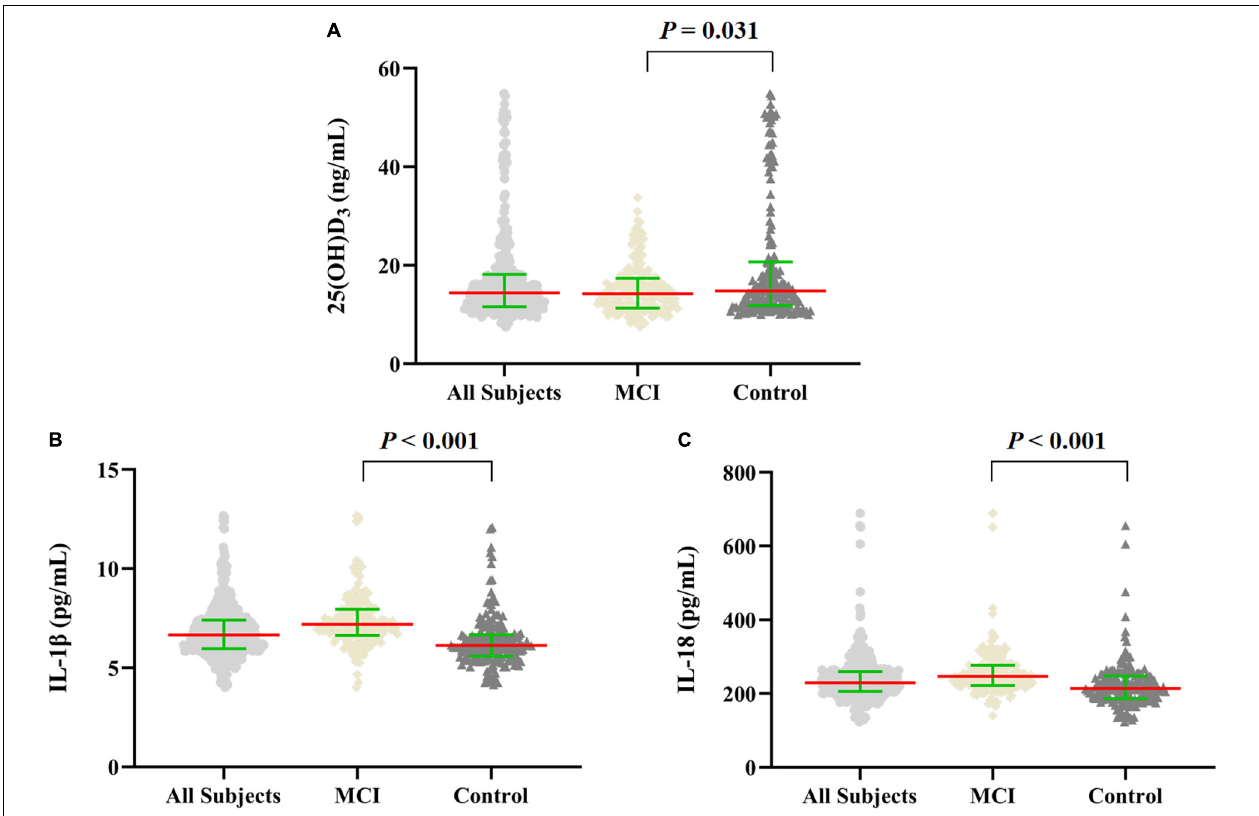
FIGURE 2 | Scatter dot plot of the levels of plasma 25(OH)D 3 and inflammatory factors in MCI and control groups. (A–C) The levels of plasma 25(OH)D 3 and IL-1 β , IL-18 in all subjects ( n = 360), and in MCI and control groups ( n = 180, respectively). The data were shown by the median with interquartile range, the red line represents the median, and the green line represents the interquartile range. Mann–Whitney U test was used for between-group comparisons.